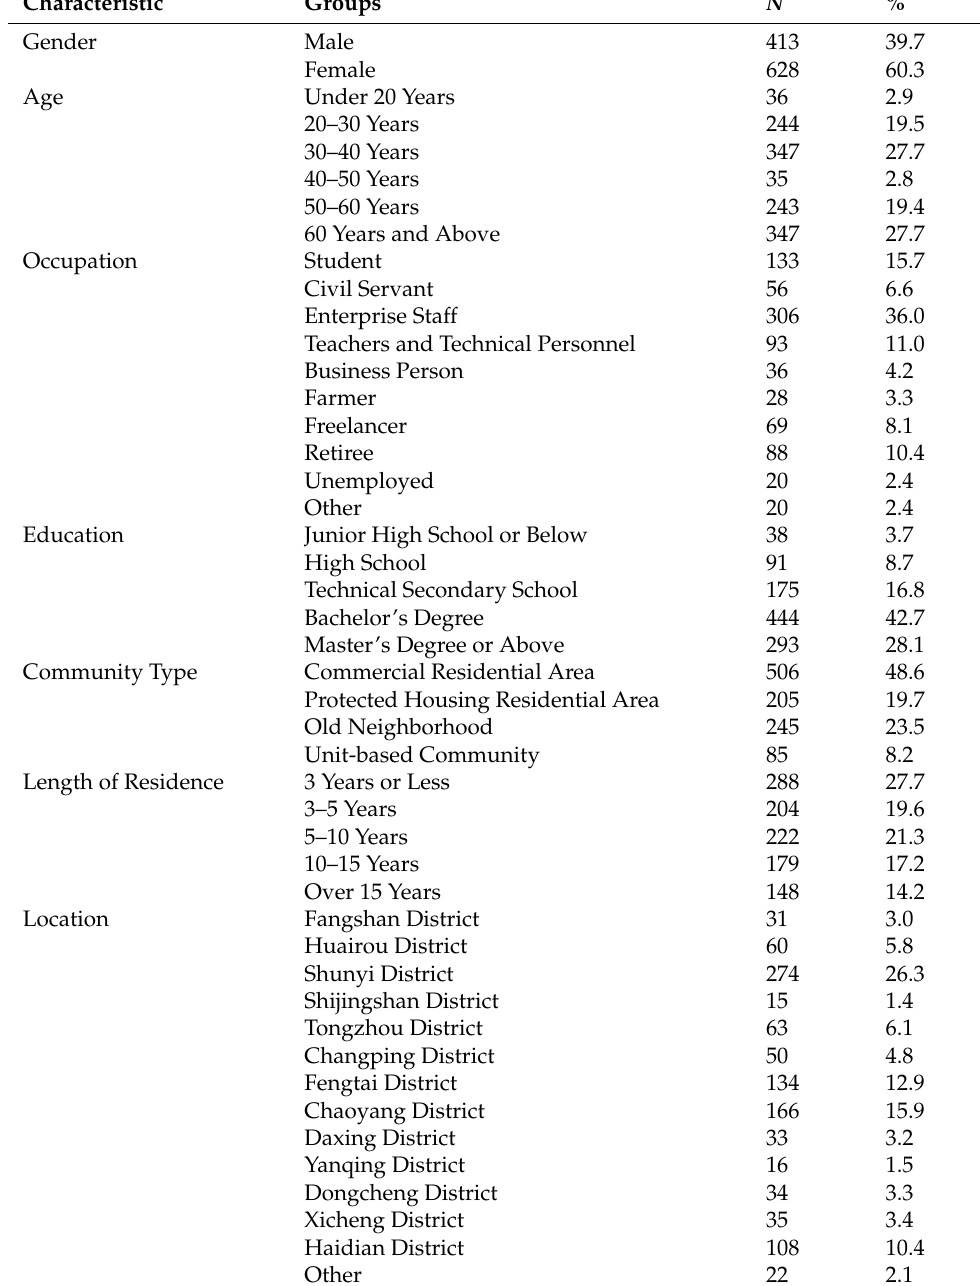
Table 2. The demographic information of the